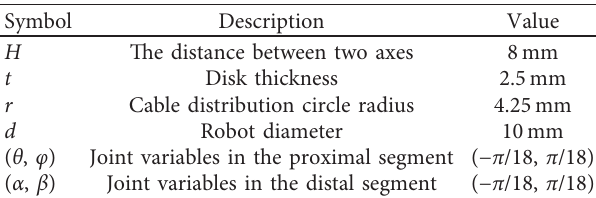
Figure 4: Cable-driven hyper-redundant robot prototype. Table 1: Parameters of the joint